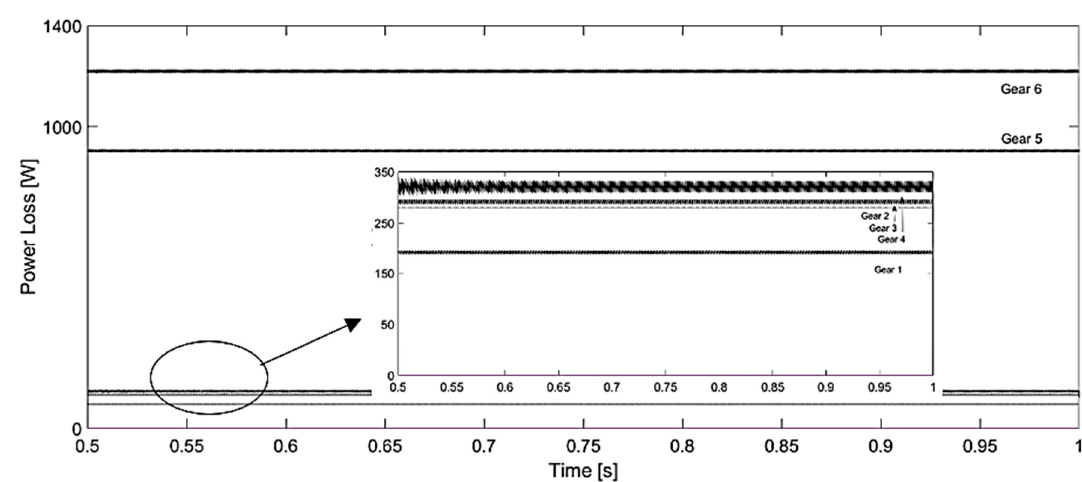
Figure 12. Power losses for WCC coated gears, scenario 1.